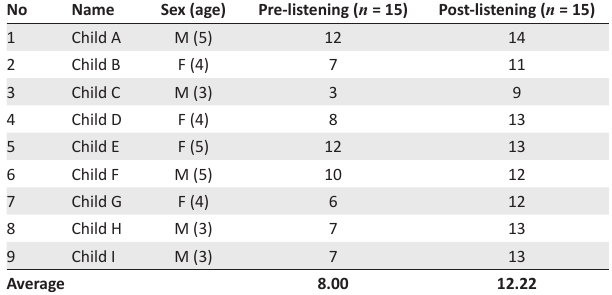
TABLE 2: Individual’s total score of pre-listening and post-listening